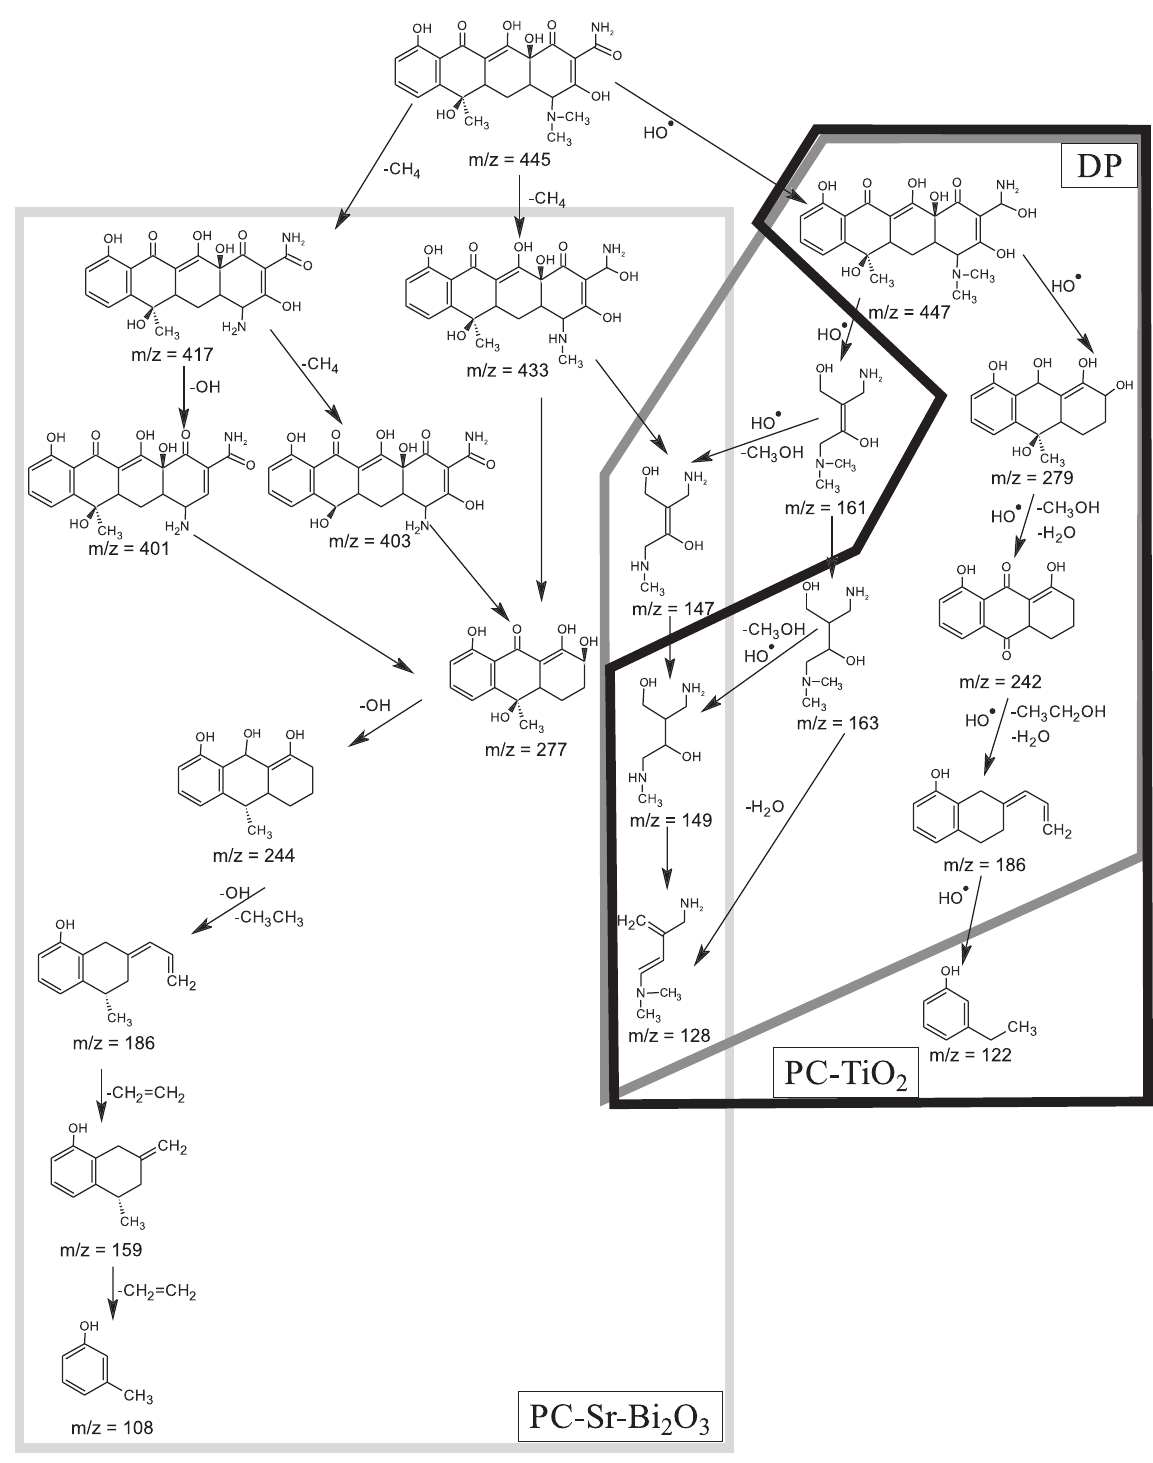
and  photocatalysis 2